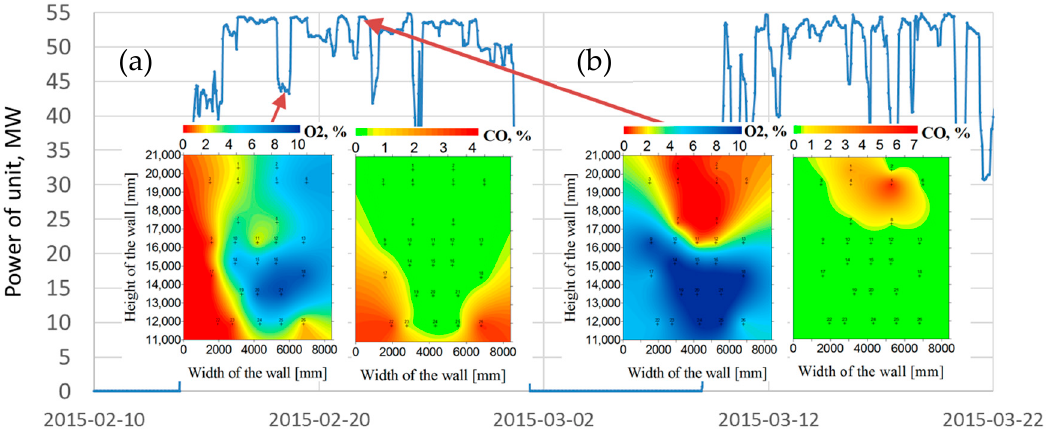
Table 3. Boiler operation during measuring of the flue gases composition in the boundary layer.